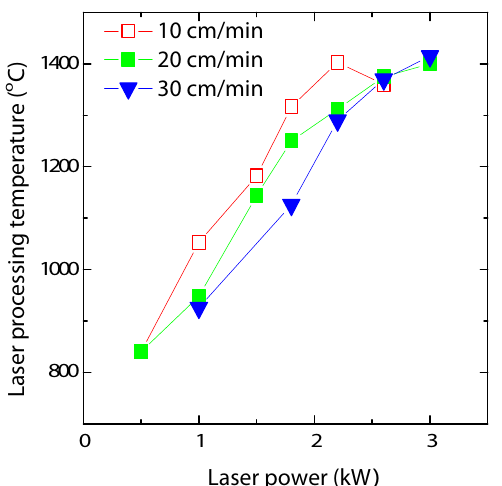
Fig. 5. Open circuit voltage of laser annealed polysilicon struc- tures as a function of processing